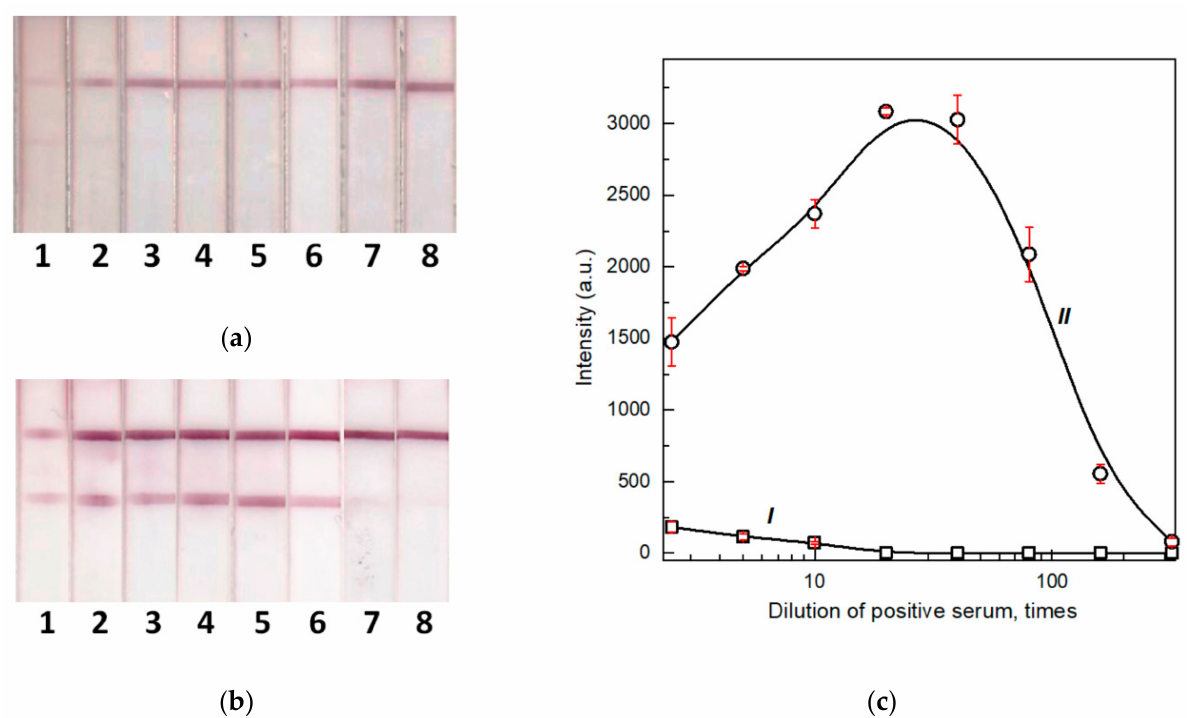
Figure 7. Images of test strips after the common ( a ) and enhanced ( b ) LFIAs of samples of pooled human serum containing antibodies to RBD SARS-CoV-2 diluted by 2.5 (1), 5 (2), 10 (3), 20 (4), 40 (5), 80 (6), 160 (7), and 320 (8) times. ( c ) Concentration dependence of the common (I) and enhanced (II) LFIA ( n =